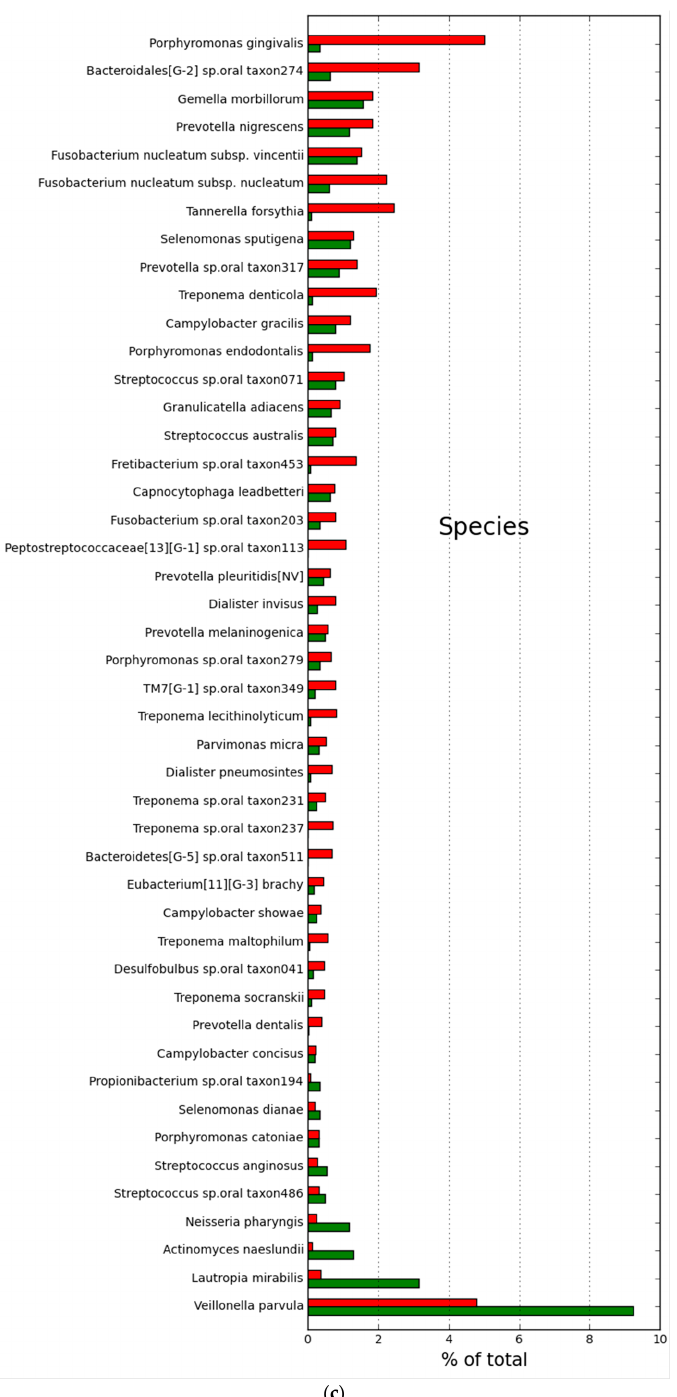
Figure 1. Genus and species level microbial differences between women with and without periodontal disease. ( a ) Panel A. Green = species/genus had significantly higher relative abundance in health; Red = species/genus had significantly higher relative abundance in disease. Disease (red) and health (green) refer to women with and without periodontal disease, respectively; ( b ) Panel B. Genera with an overall relative abundance ≥ 0.2%, and an adjusted p ≤ 0.05, ordered by the difference of relative abundance. Red and green bars are for women with and without periodontal disease, respectively; ( c ) Panel C. Species with an overall relative abundance ≥ 0.2% and an adjusted p ≤ 0.05, ordered by the difference of relative abundance. Red and green bars are for women with and without periodontal disease,